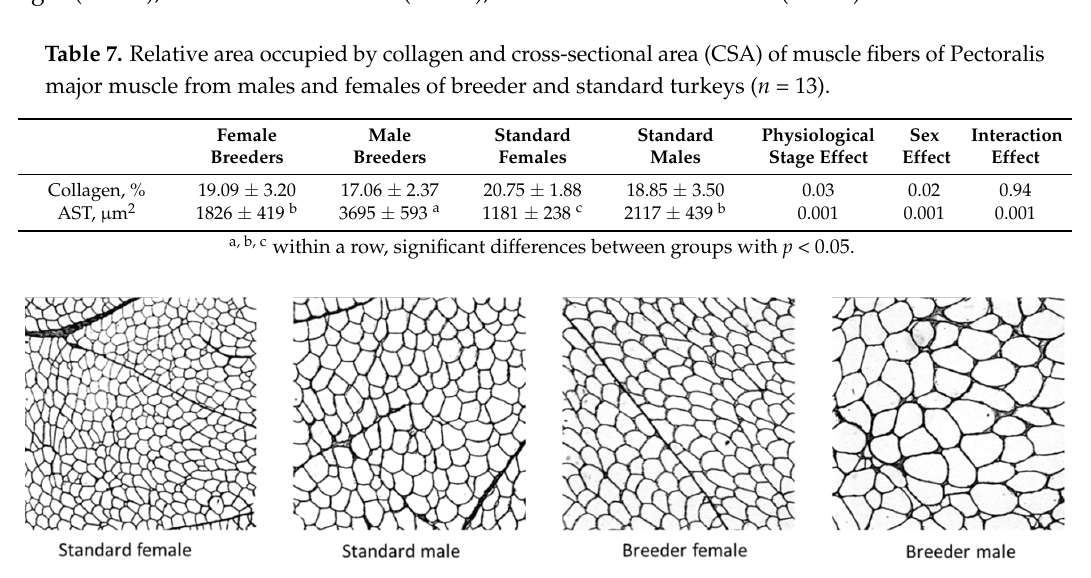
Figure 1. Cross-sectional area of Pectoralis major muscle from males and females of breeder and standard turkeys ( n = 13, magnification ×5).